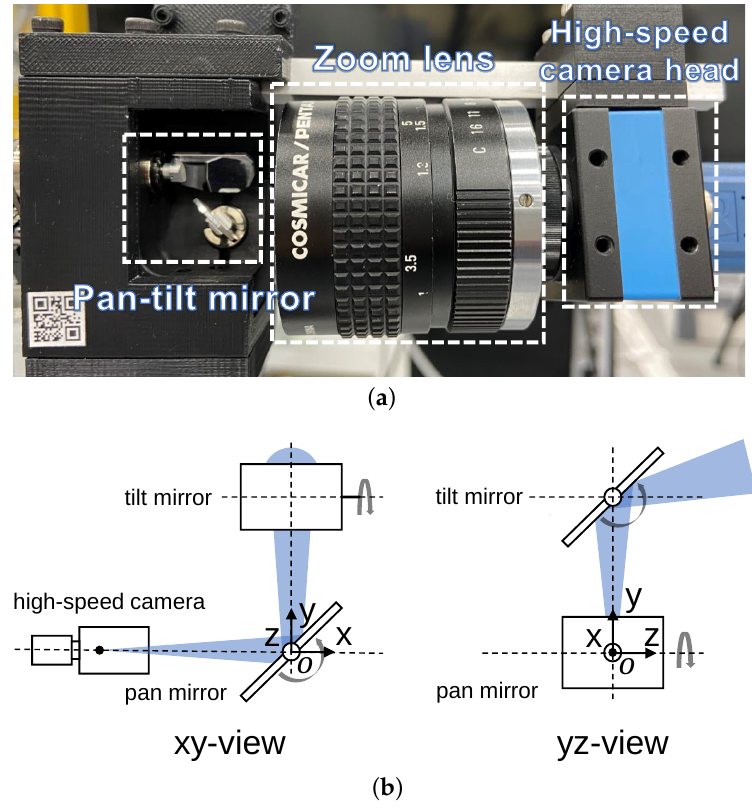
Figure 5. ( a ) Overview and ( b ) geometry of the galvanometer-based reflective PTZ